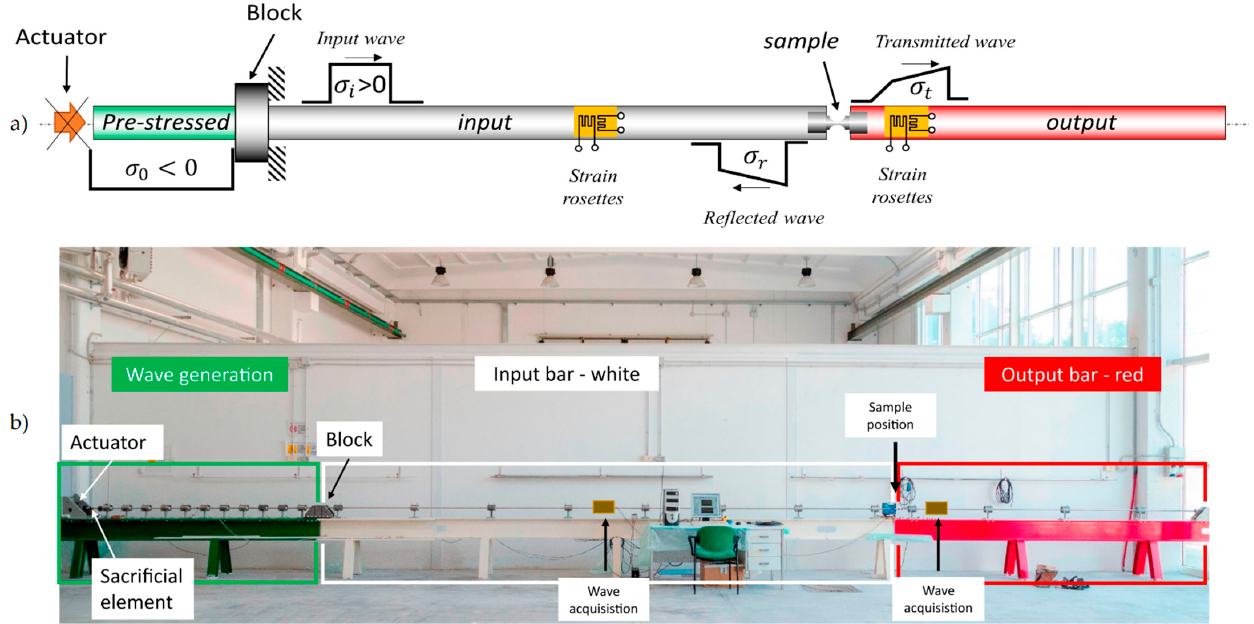
Figure 1. ( a ) Scheme of the direct Split Hopkinson bar, ( b ) direct Split Hopkinson bar facility [33].